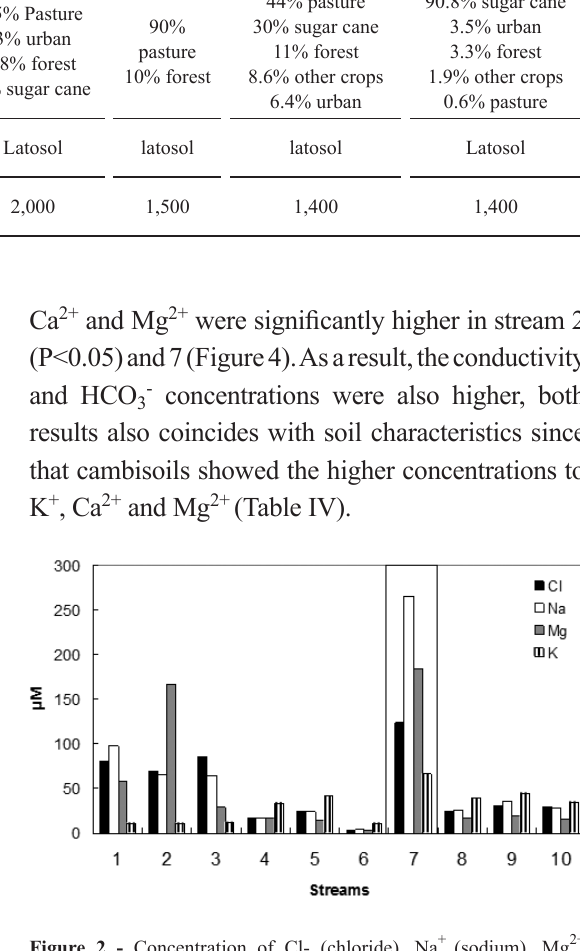
Land use types, soil cover and annual precipitation of each sampling sites.